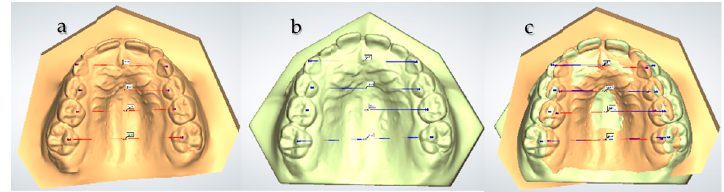
Figure 3. Test Group—Leaf: Maxillary arch before ( a ), after the expansion ( b ) and the superimposition of the two digital casts ( c ) with traced interdental width.